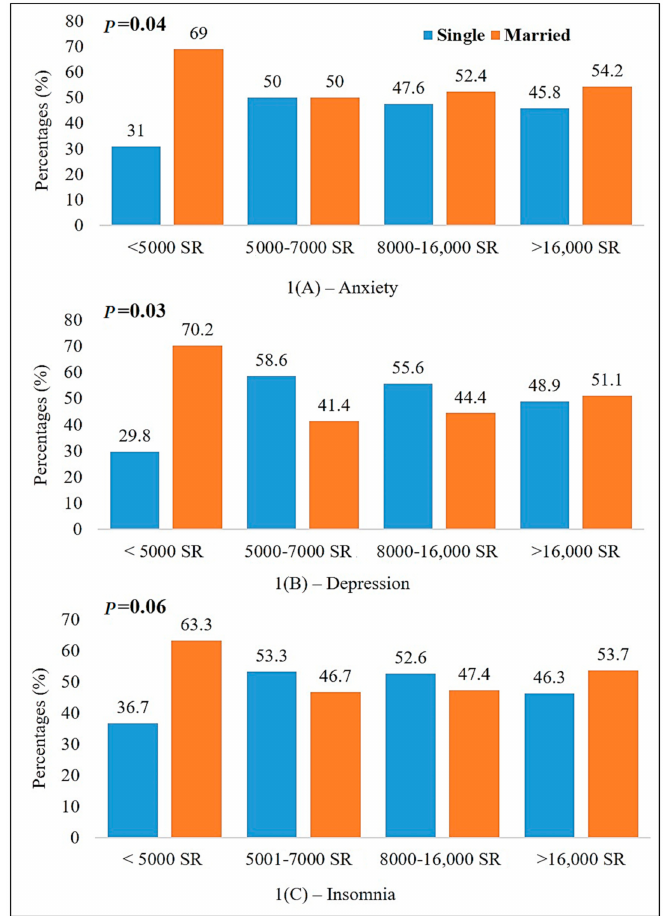
Figure 1. Prevalence of different mental health disorders according to income and marital